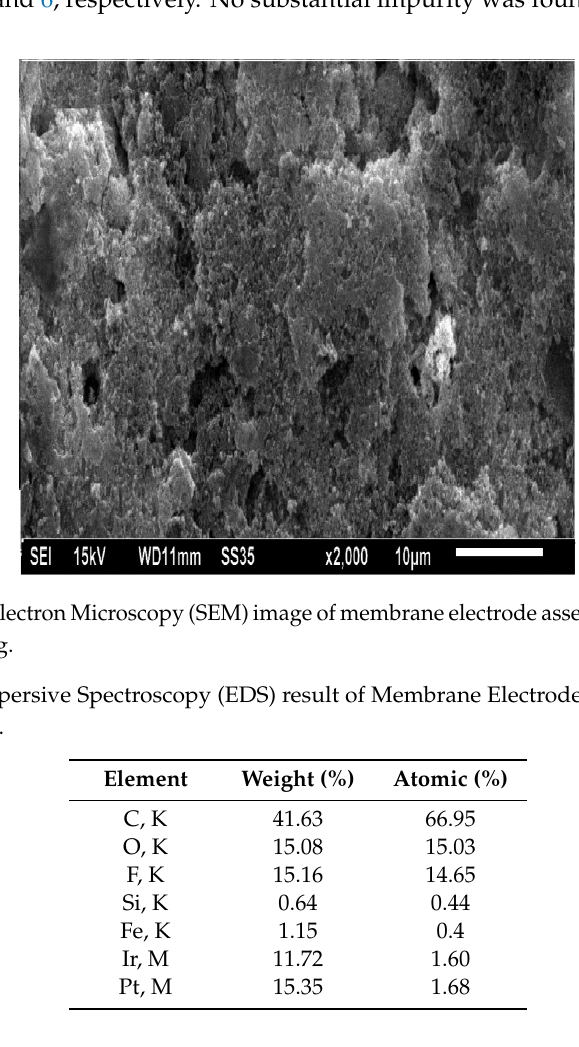
Table 6. Energy Dispersive Spectroscopy (EDS) result for membrane electrode assembly (MEA) cathode (hydrogen) side.